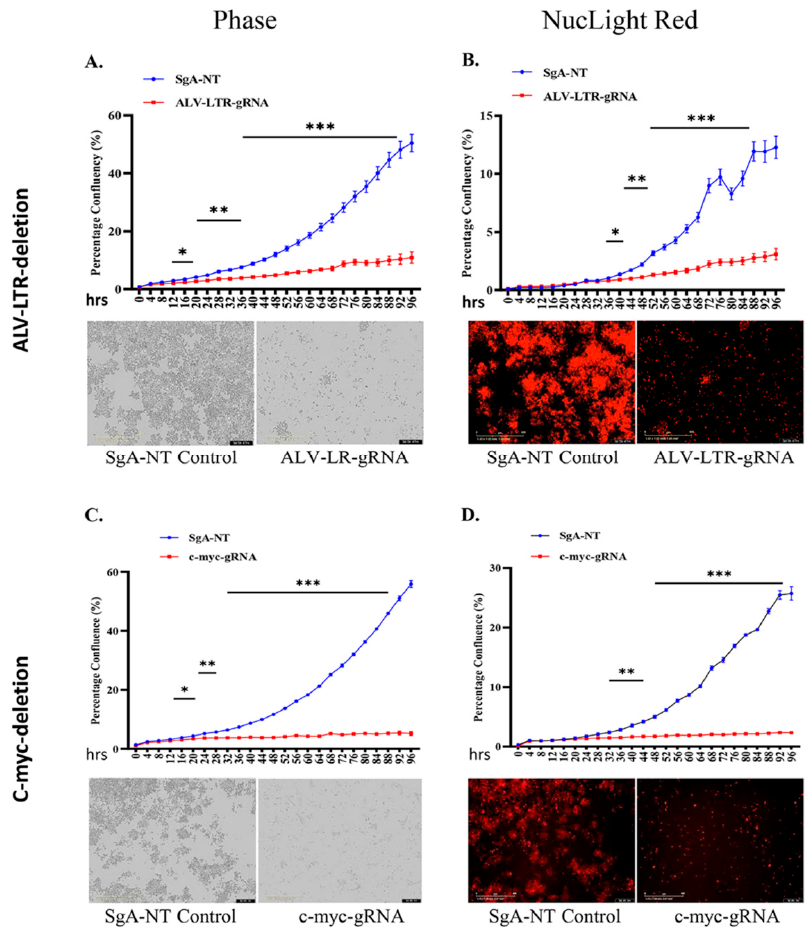
Figure 2. Proliferation of gRNA-transfected cells monitored in real time using the IncuCyte S3 live imaging system. gRNAs targeting ALV-LTR ( A , B ) or c-myc ( C , D ) transfected cells were subjected to proliferation assay using NucLight Rapid Red Reagent in IncuCyte S3 imaging system. Phase ( A , C ) and red ( B , D ) object confluency of each cell population were determined every 4 h for 96 h from five separate regions per well and four wells per sample by IncuCyte S3 and compared with SgA-NT control. Growth curves (upper panels) are shown as mean ± standard error (SE) representative of three independent experiments. Asterisk (*) indicates statistically significant differences between gRNA-edited cells and SgA-NT cells at different time points. * p <0.05; ** p < 0.01; *** p < 0.001. Phase and red object images (bottom panels) are representative of 72 h time points. The scale bar, 400 µ